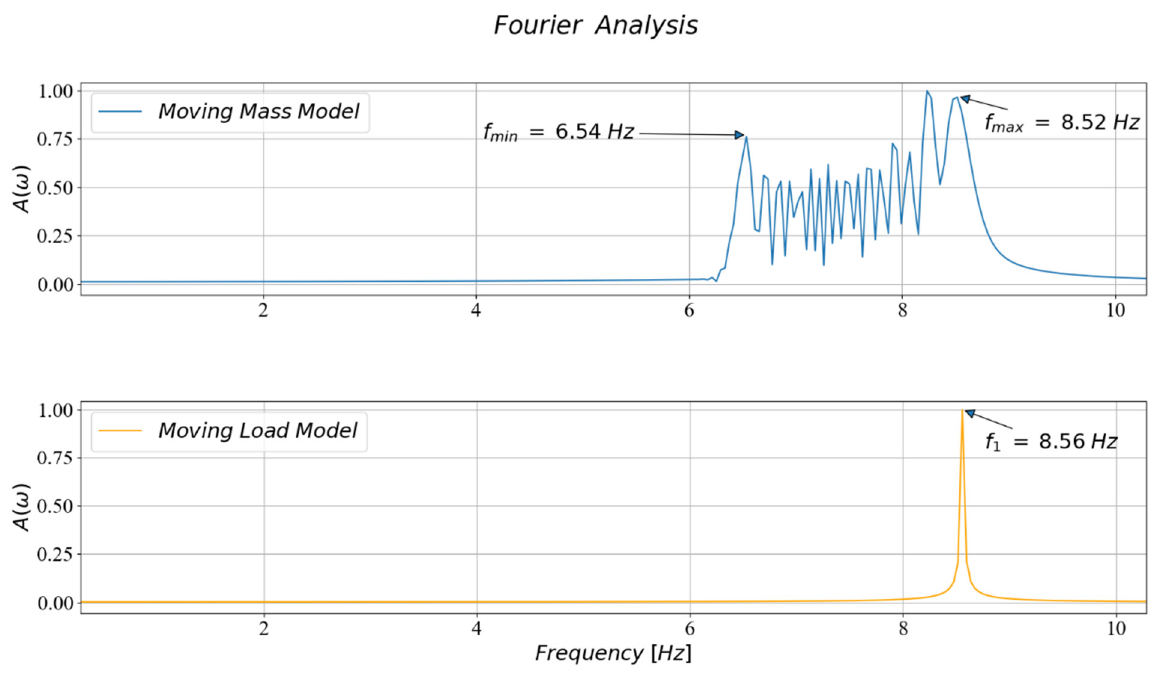
Figure 7. FFT of the displacement time history at station x = 7L/16 of the bridge deck for the moving mass ( top ) and the moving load ( bottom ) representations of a m = 38.6 kg mass speeding at v = 0.247 m/s .